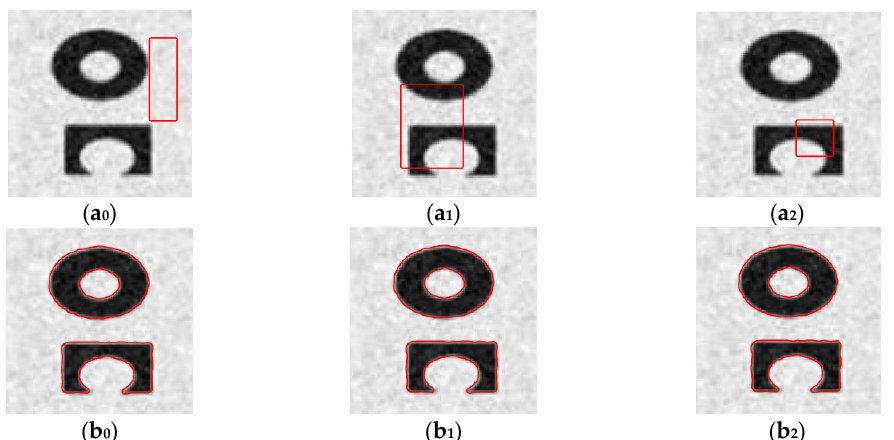
Figure 3. Segmentation results of the initial rectangular profile: ( a 0 – a 2 ) are the original images with different initial contours. ( b 0 – b 2 ) is the segmentation result of NFD-LIF model.